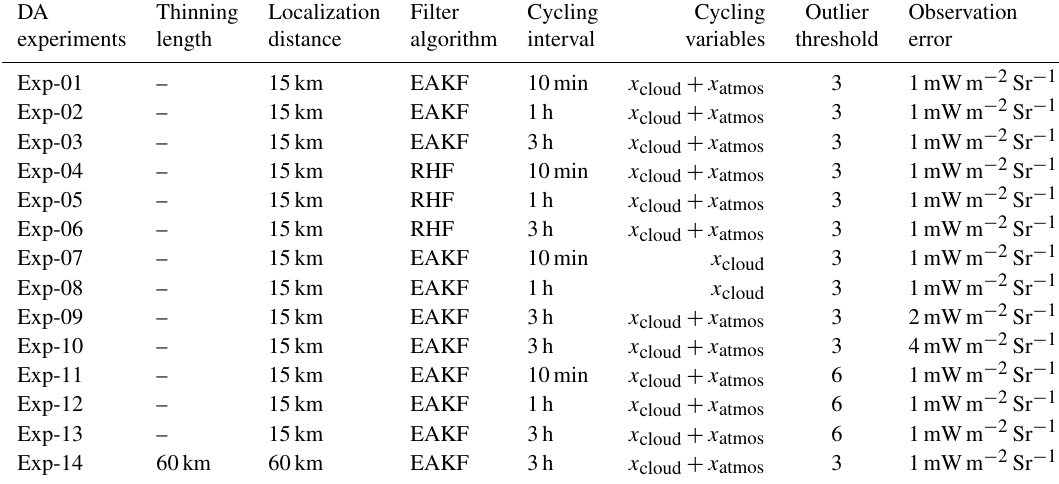
DA Thinning Localization Filter Cycling Cycling Outlier Observation experiments length distance algorithm interval